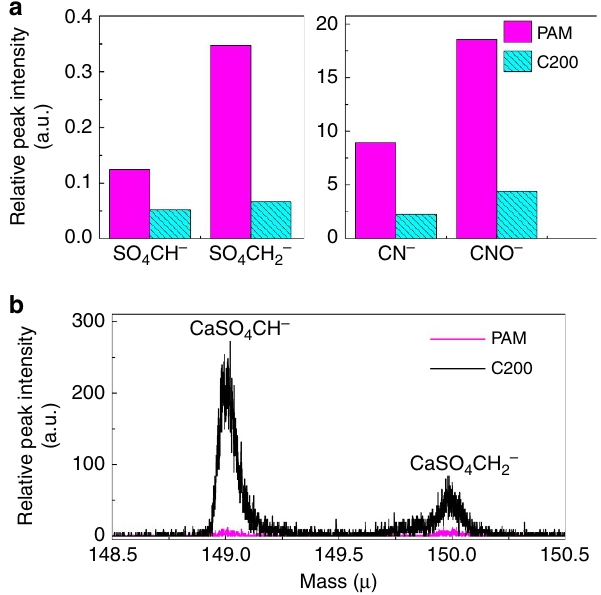
Figure 4 | ToF-SIMS tests of PAM and C200. ( a ) Relative peak intensity of the negative ions representing the end (SO 4 CH (cid:2) and SO 4 CH 2 (cid:2) ) and side (CN (cid:2) and CNO (cid:2) ) functional groups of the original PAM and C200, with CH (cid:2) as the reference. The decreased relative peak intensity of the ions shows the reduction of the end and side groups in C200. ( b ) Peaks of CaSO 4 CH (cid:2) (mass 149.0) and CaSO 4 CH 2 (cid:2) (mass 150.0) appear in C200, and their relative intensities do not change before and after being stretched 60 times, indicating the strong connection between CNS and PAM end group. C200 represents PAM/CNS NC gel with 200p.p.m. CNS concentration.